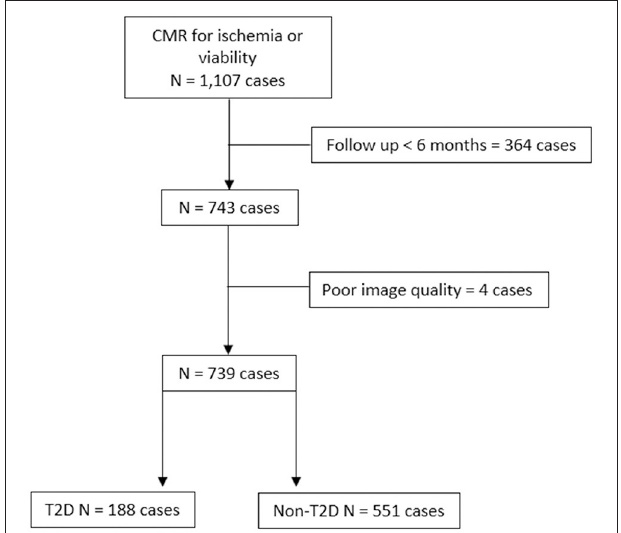
FIGURE 1 | Flow diagram of the patient enrollment